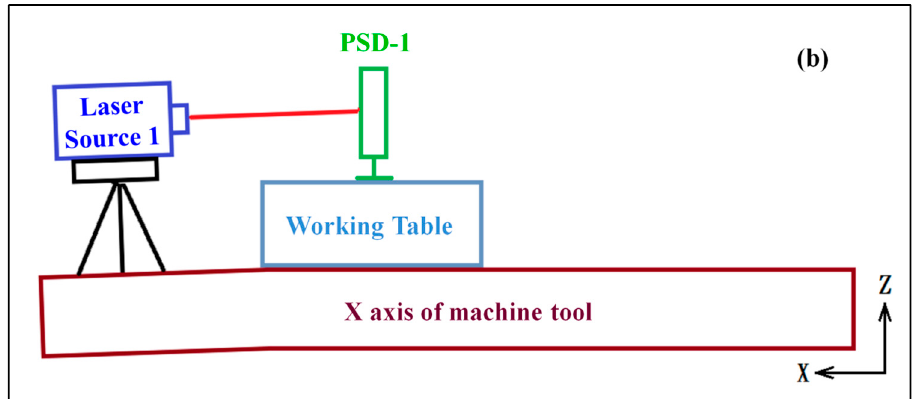
Figure 6. Pitch angle error of the laser source due to the motion of the working table: ( a ) moving away; and ( b ) moving closer to the laser source.